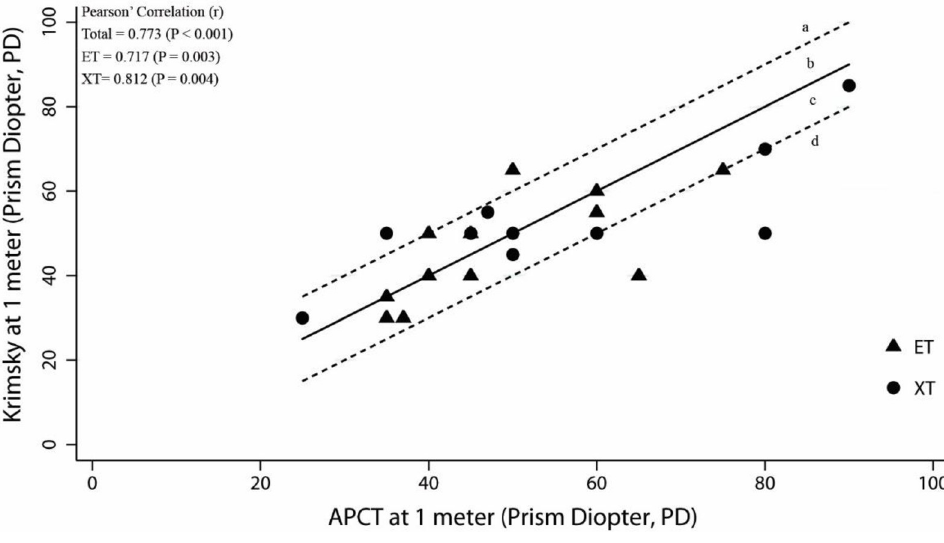
Fig 4. The relationship between angle of deviation from the Krimsky test with APCT at N. The solid line is the line of equality and the zone between dotted lines represents range ± 10 PD of the APCT values. The acceptable area were b and c. The unacceptable area were a and d. (ET = esotropia; XT =